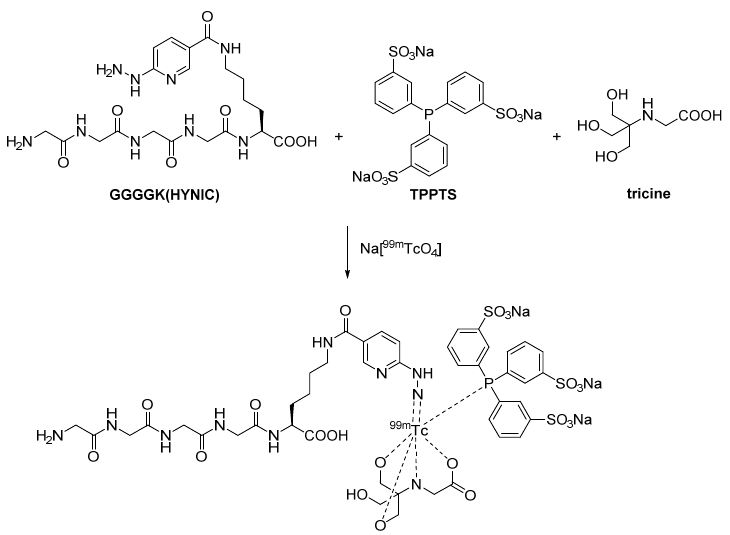
Figure 16. Assumed complex formation of technetium-99m coordinated by three ligands [112].